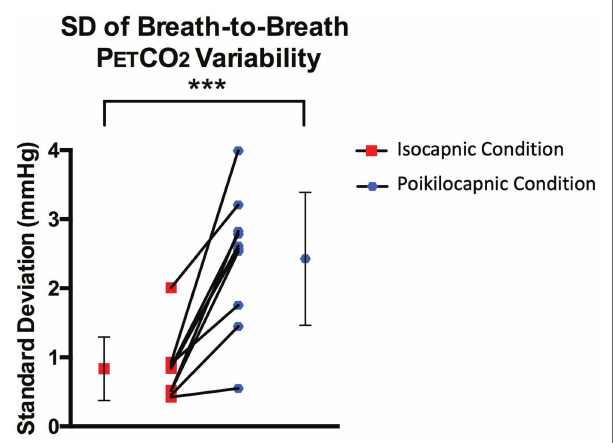
FIGURE 2 | Respiratory data for both resting-state conditions. SD of breath- to-breath P ET CO 2 variability in the isocapnic spontaneous breathing condition (when P ET CO 2 was kept constant) denoted with red squares, and poikilocapnic spontaneous breathing condition (when P ET CO 2 was free to change) denoted with blue circles. Connecting lines in the middle of the graph associate each individual subject’s condition (the mean SD of breath-to- breath variability for the isocapnic and poikilocapnic conditions). The symbol and error bars beside each line graph side denotes the mean and SD of all 10 subjects for each condition. *** denotes p < 0.001.